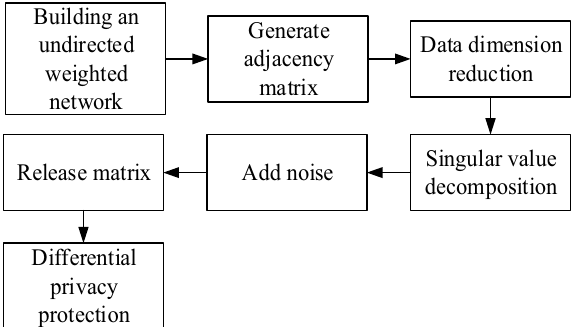
Figure 1. Flow chart of differential privacy protection for network sensitive